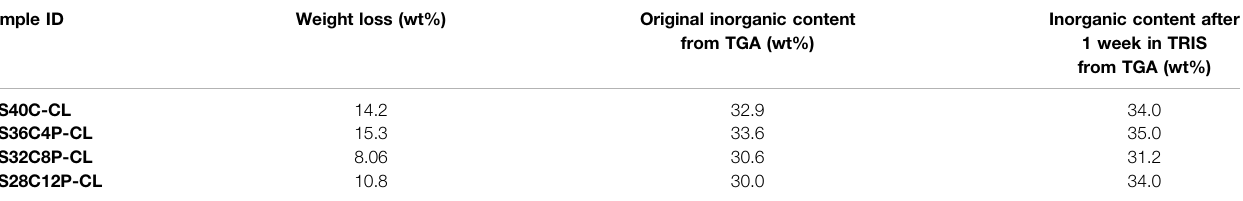
TABLE 4| Weightloss of hybrids after 1week ofTRIS buffer dissolution and the variation ininorganic wt% inthe hybrids before and after 1 weekTRIS dissolution measured from TGA. Sample